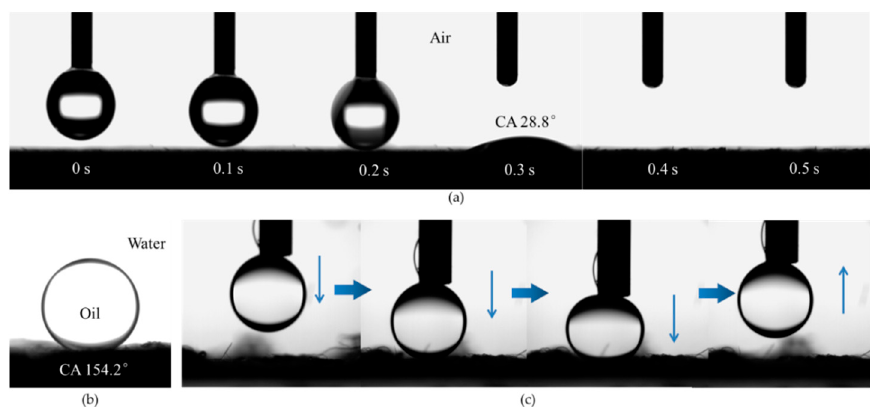
Figure 1. SEM images of a thin microfiber filter: ( a ) surface, ( b ) cross section.